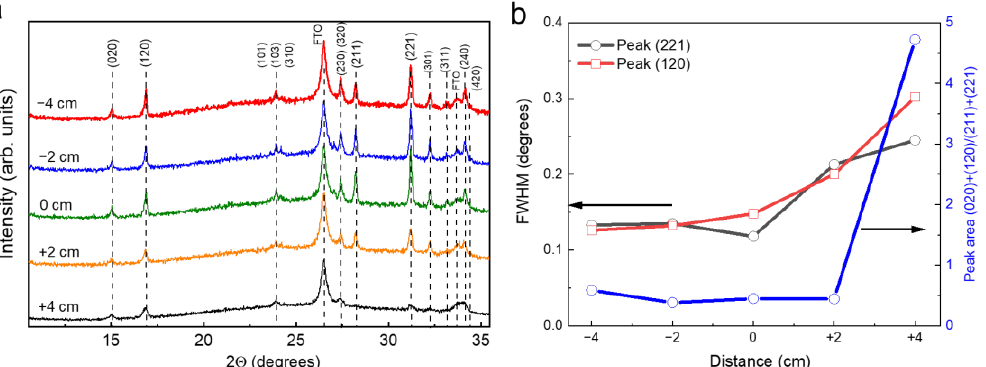
Figure 3. ( a ) XRD patterns of Sb 2 Se 3 seed layer deposited at different sample heating zone distances. All XRD peaks were assigned to orthorhombic Sb 2 Se 3 phase (PDF 01-089-0821) and SnO 2 (PDF 00-041-1445). ( b ) FWHM and ratio of (020) + (120) peak area to (221) + (211) as a function of sample heating zone distance.